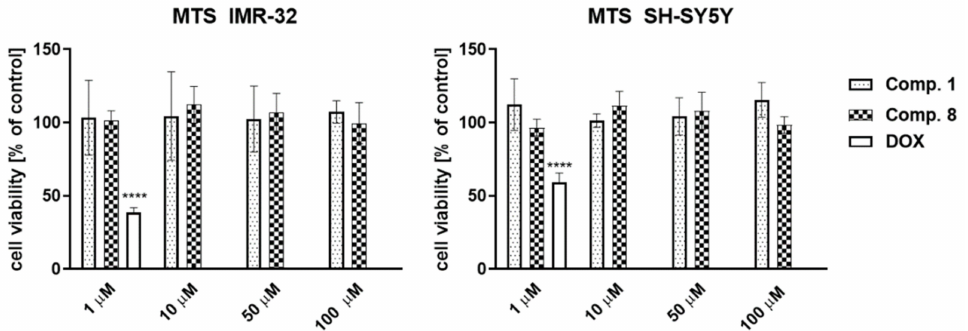
Figure 1. Viability of IMR-32 (left) and SH-SY5Y (right) neuroblastoma cells’ after 24 h of incubation with compounds 1 , 8 and the reference cytostatic drug doxorubicin (DOX, 1 µ M). Statistical signifi- cance was evaluated by one-way ANOVA, followed by Bonferroni’s comparison ( ∗∗∗∗ p <